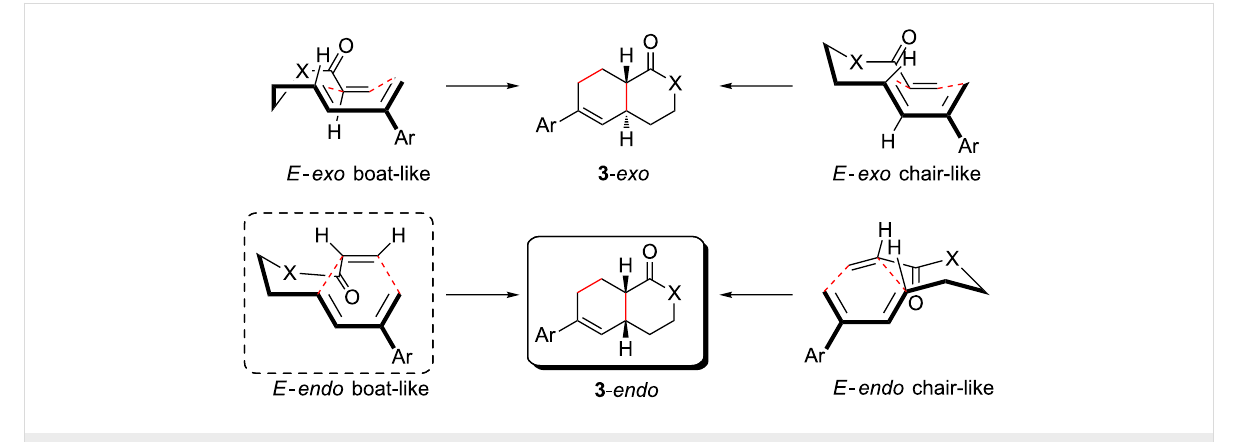
Scheme 2: Stereochemical outcome of the